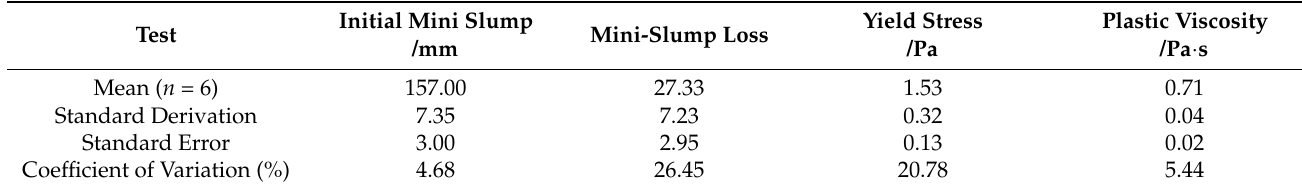
Table 4. Repeatability of the responses at central